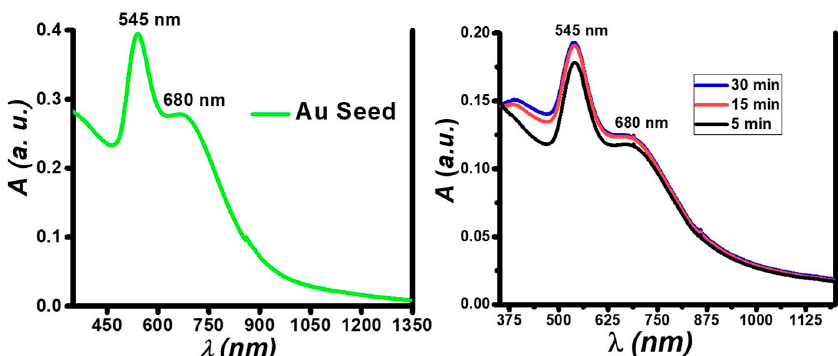
Figure 5. UV-Vis spectra of large, anisotropic AuNPs (left) and time-based formation of Au-Ag nanotwins (right) using the large, anisotropic AuNPs as seeds. The left AuNP seeds are generated by irradiation of 1 mM Au(I) precursor for 120 min using Source 1. The right panel Au-Ag nanotwins are formed by irradiating a 1:1 solution containing the AuNP seed and 10 mM AgNO 3 using Source 1.